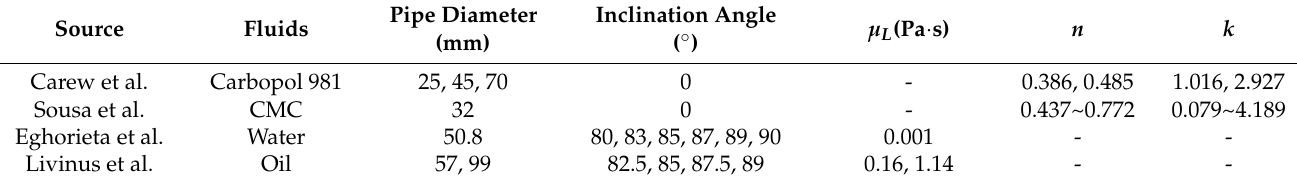
Table 3. Sources and properties of the database used for correlation